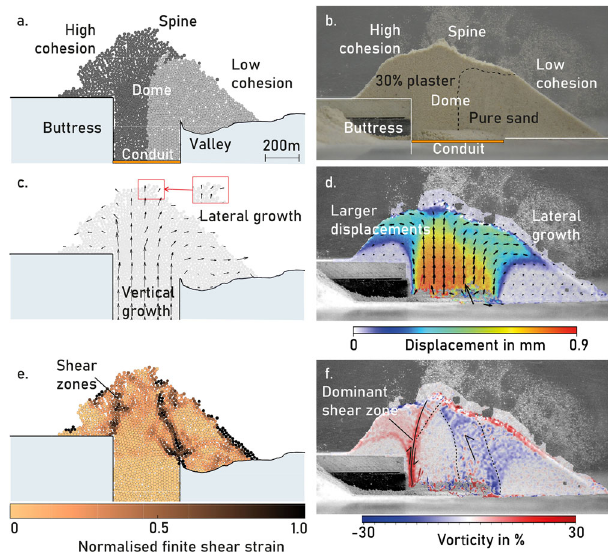
Fig. 7 Computational particle fl ow and analog modeling. a 2D PFC model and b analog sandbox model, both showing high and low cohesion material extruded from a conduit, with a stable buttress to the left side of the conduit exit. c , d Velocity vectors showing primarily upward movement above the conduit, with lateral fl ank motion. Spine emplacement can be seen at the top of the dome, where the cohesion contrast is forcing direct lateral motion. e , f Strain accumulation showing fault formation broadly in line with the conduit exit. Data in f is displayed as vorticity, which represents shear